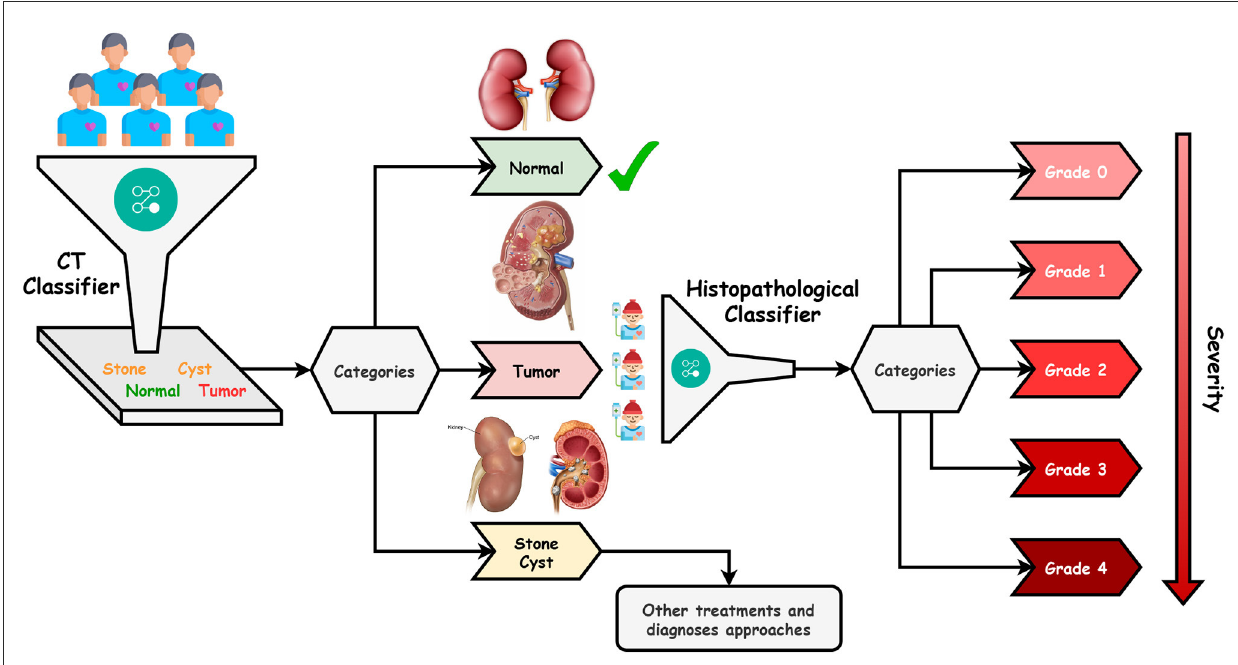
FIGURE3 The proposed DRDC framework classification